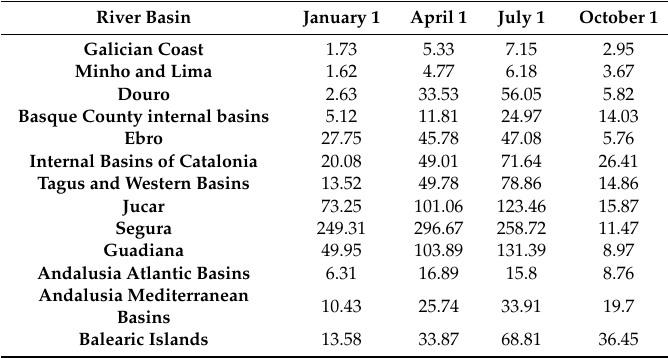
Table A1. Water exploitation index plus by river basin for the four seasons of 2015 (%).